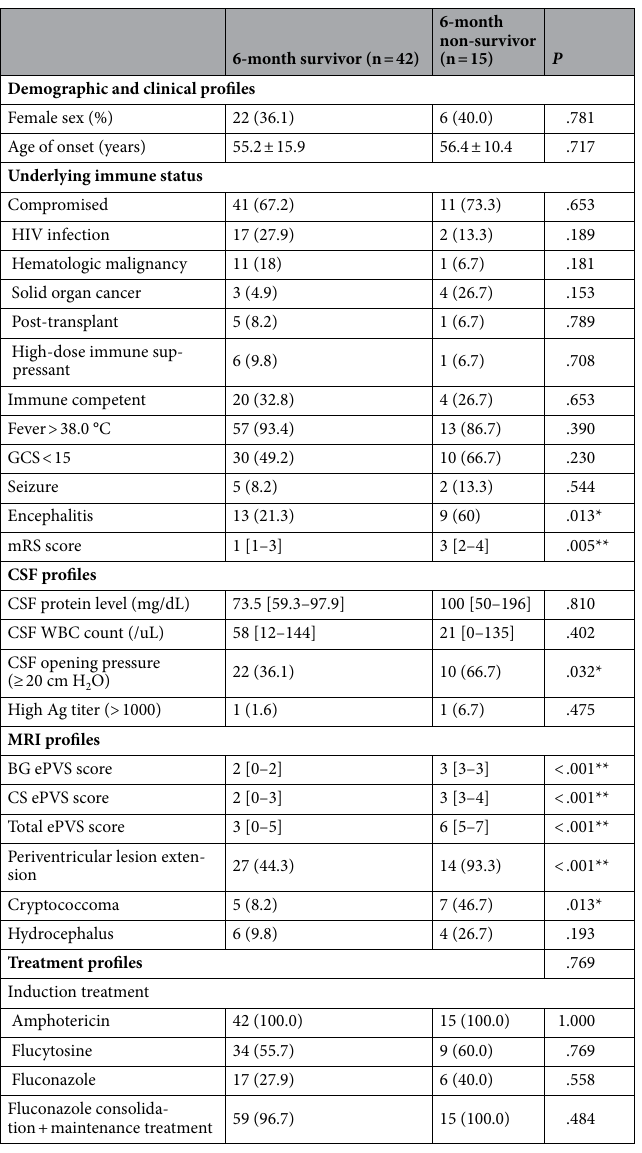
Table 3. Univariate analysis for the factors associated with 6-month mortality. Data are reported as mean ± standard deviation, or as median [interquartile range, IQR]. HIV human immunodeficiency virus, GCS Glasgow coma scale, mRS modified Rankin scale, CSF cerebrospinal fluid, WBC white blood cell, ePVS enlarged perivascular space. * P < .05 and ** P <